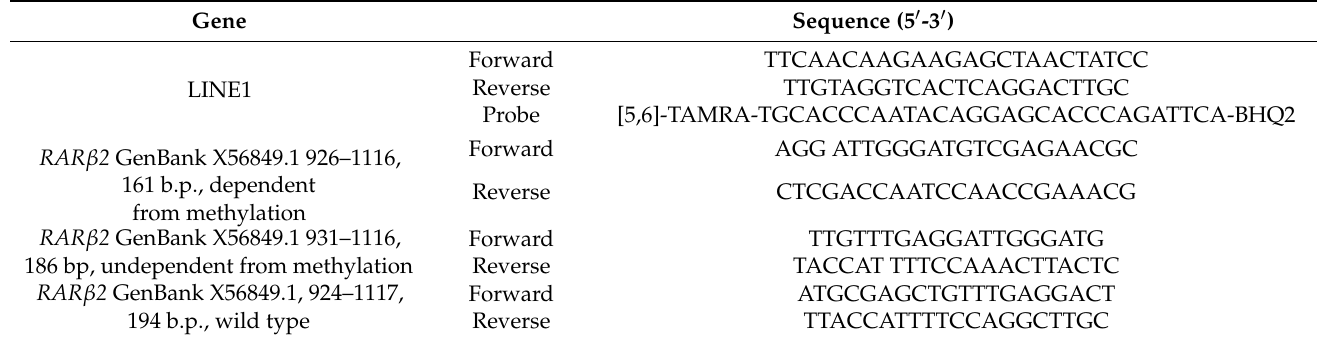
Table 4. Sequences of primers used in